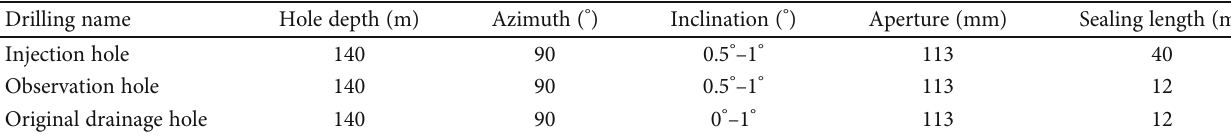
Figure 4: Schematic diagram of drilling layout of liquid CO Table 2: Drilling parameter design table.